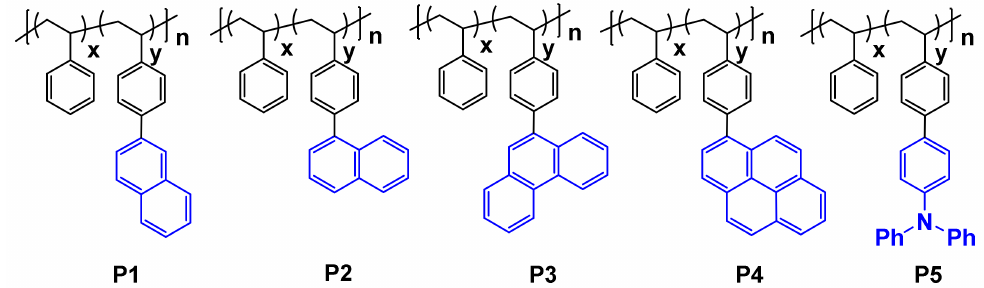
Figure 1. Structure of investigated polymers P1 – P5